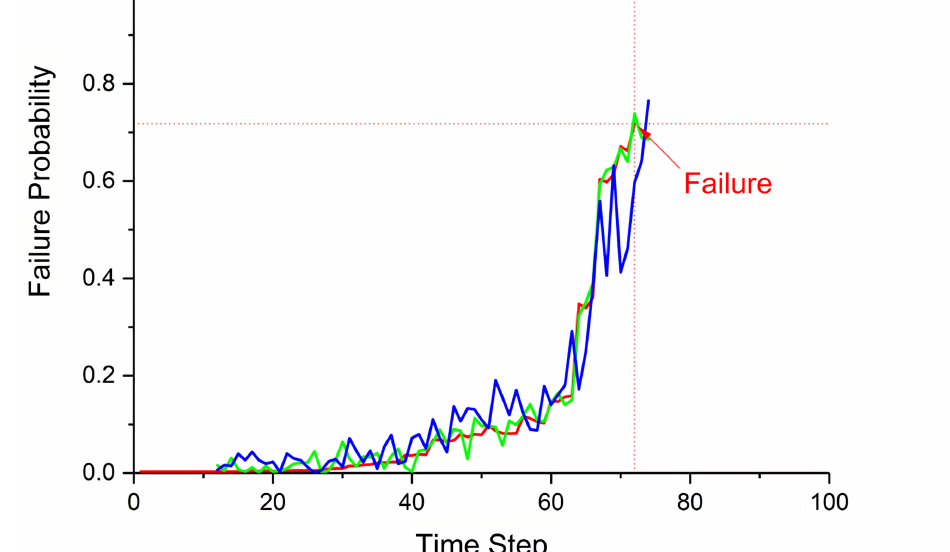
Figure 7. Failure prediction at T + 2.